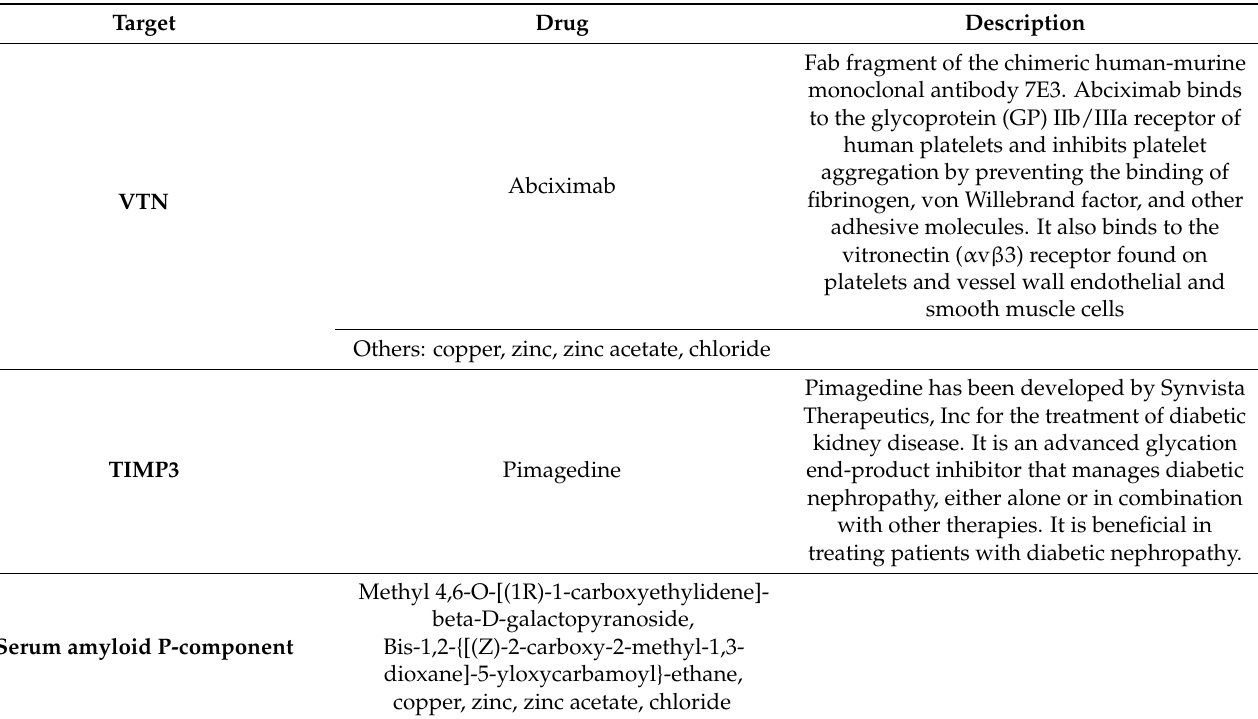
Table 2. Potential drugs for the targeted molecules found in omic studies. For Notch3, endostatin, HTRA1, E2F4, we have not found any available